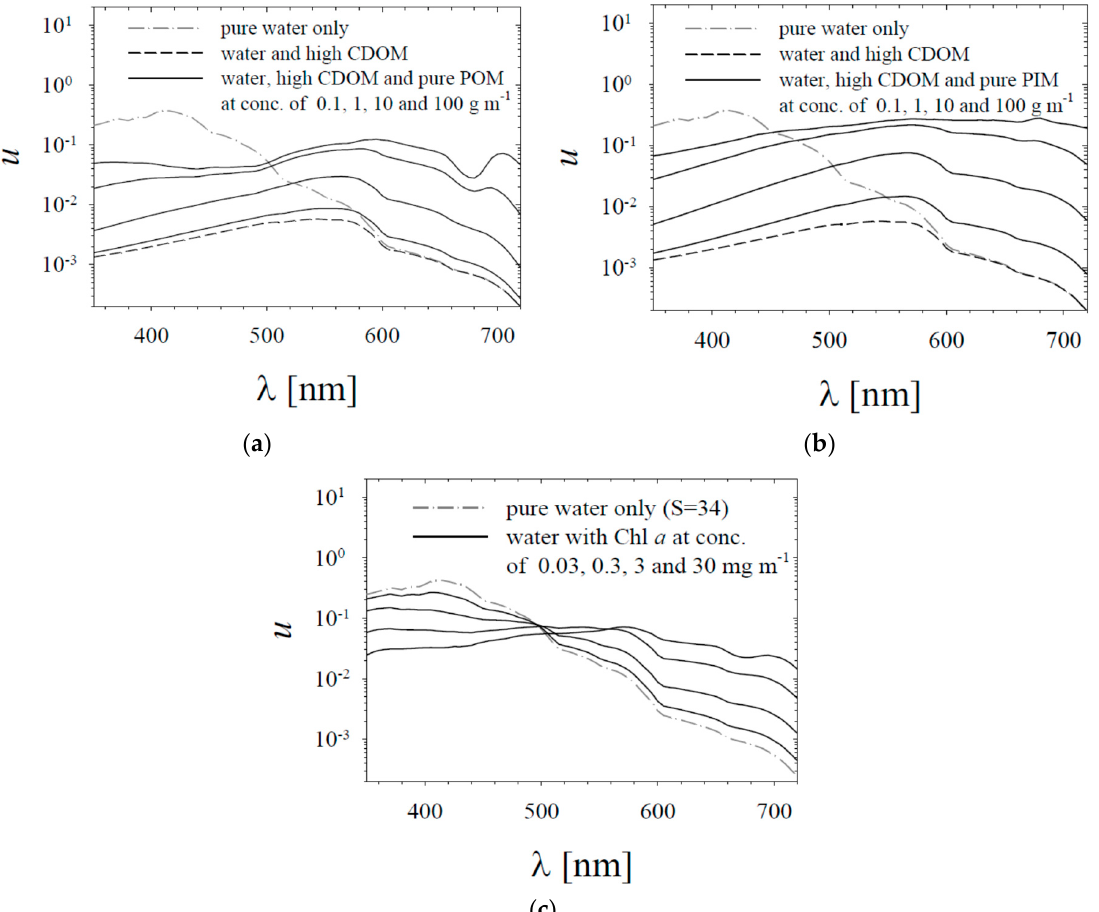
Figure 9. Example of results calculated using the simple models. Spectra of the u ratio (taken here as a simple proxy for the remote-sensing reflectance), calculated for: ( a ) model A and the case of high chromophoric dissolved organic matter (CDOM) concentration (assuming a g (440) = 0.7 m − 1 ) and for di ff erent concentrations of the pure POM fraction; ( b ) as a, but for di ff erent concentrations of pure PIM fractions; ( c ) spectra calculated with model B for di ff erent chlorophyll a concentrations. On each panel, lines representing pure water are also plotted for reference.